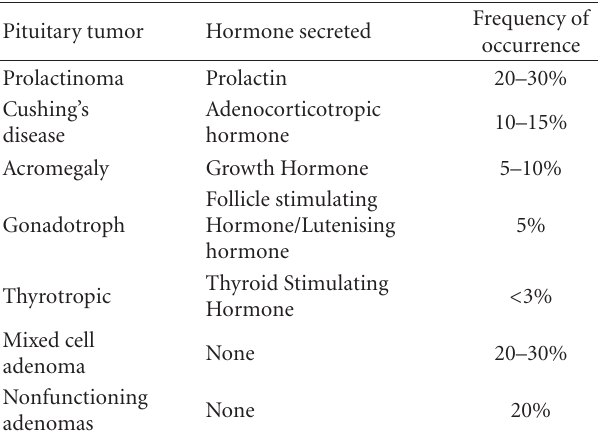
Table 2: Pituitary tumors and frequency of